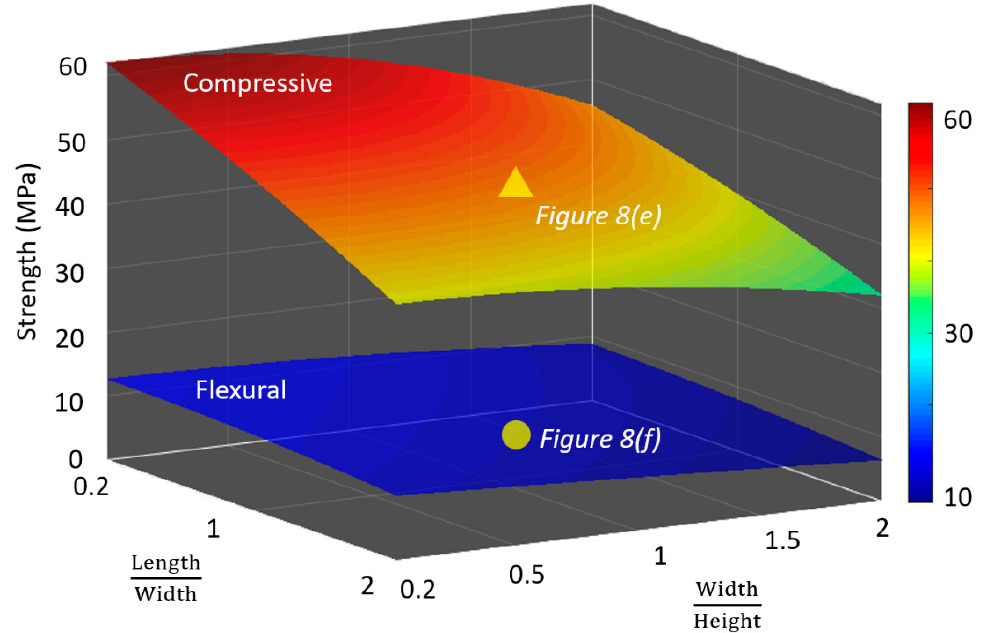
Figure 9. Variations of the compressive and flexural strengths of the OPC with respect to the length- to-width and width-to-height